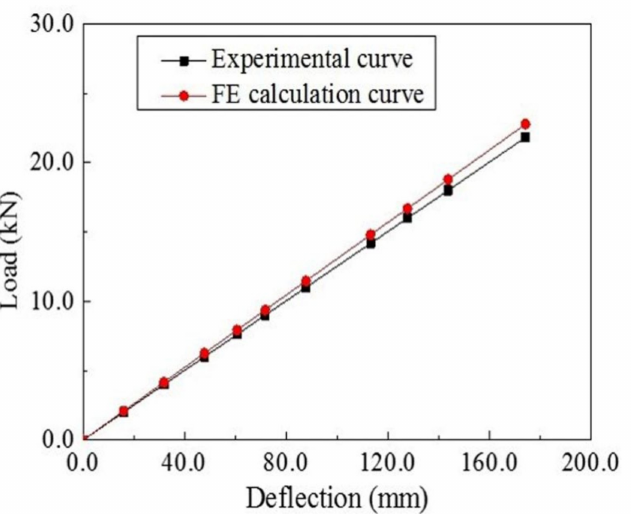
Figure 6. The load-deflection curves of the composite leaf spring under the three-point bending test and FE